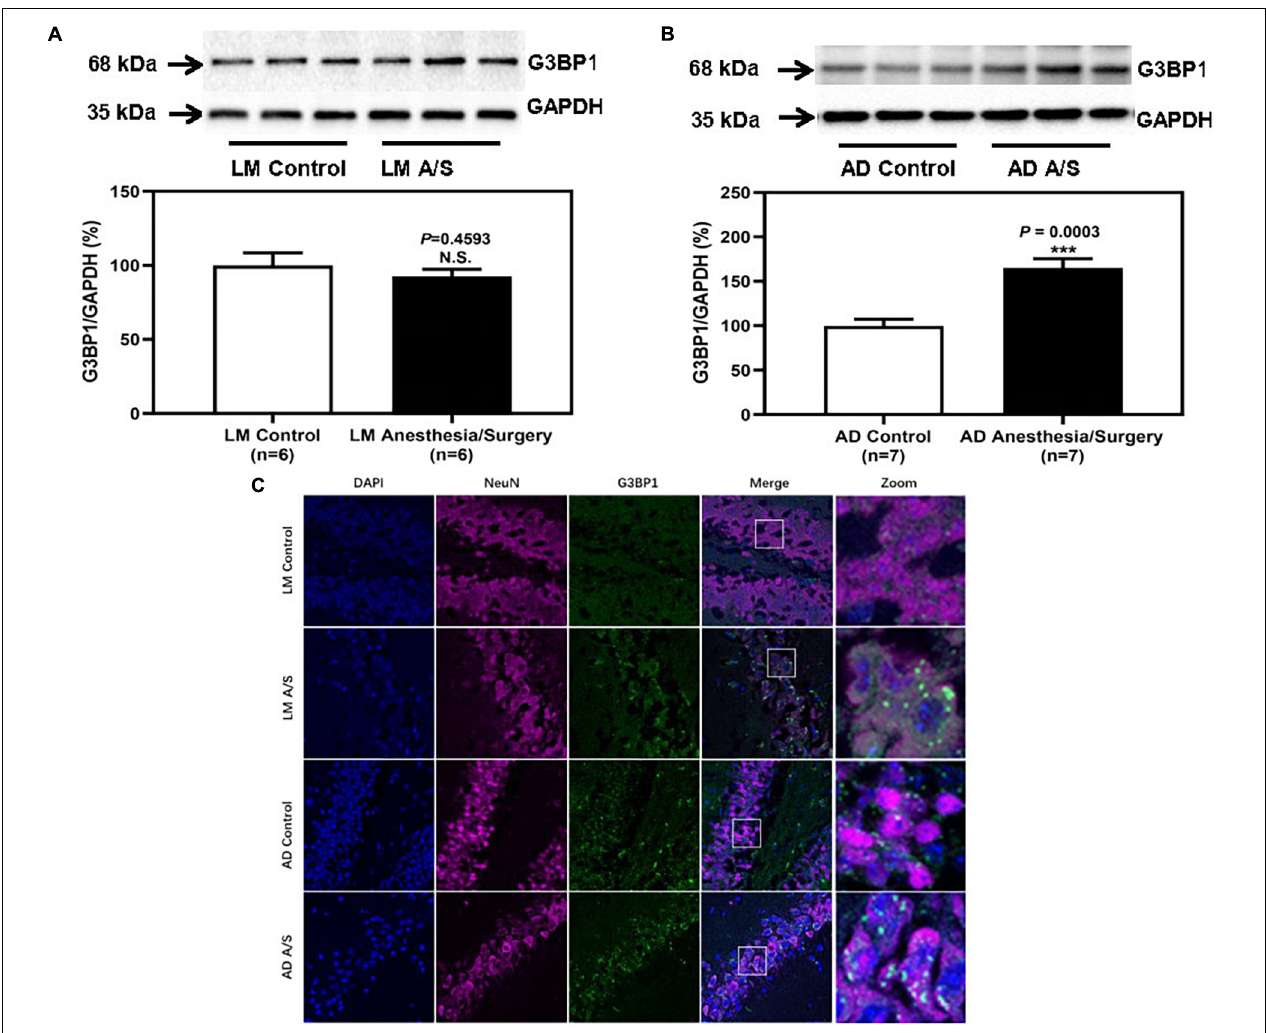
FIGURE 5 | The effect of anesthesia and surgery on the levels of SGs in the hippocampus of LM mice and 5XFAD Tg mice. G3BP1 expression in the hippocampus of postoperative 24 h of LM mice (A) and 5XFAD Tg mice (B) in control and anesthesia/surgery group. (C) Immunostaining of G3BP1 positive neurons in the hippocampus of LM mice and 5XFAD Tg mice in control and anesthesia/surgery group. The hippocampus level of G3BP1 was significantly increased in 5XFAD Tg mice but not LM mice at postoperative 24 h. The immunostaining of G3BP1 showed that G3BP1 and hippocampus neuron (NeuN) were colocalized. Results are expressed as mean ± SEM. Student’s t -test. N.S., P > 0.05 vs. untreated controls. *** P < 0.0005 vs. untreated